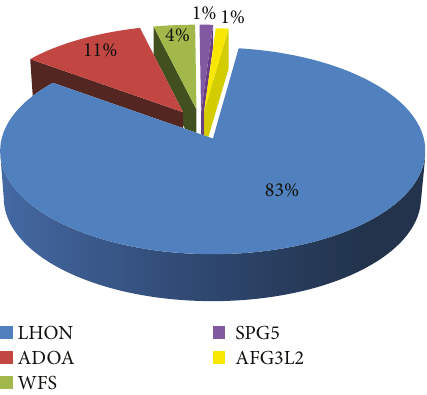
Figure 1: The genetic testing pro fi le of patients with hereditary optic neuropathy.